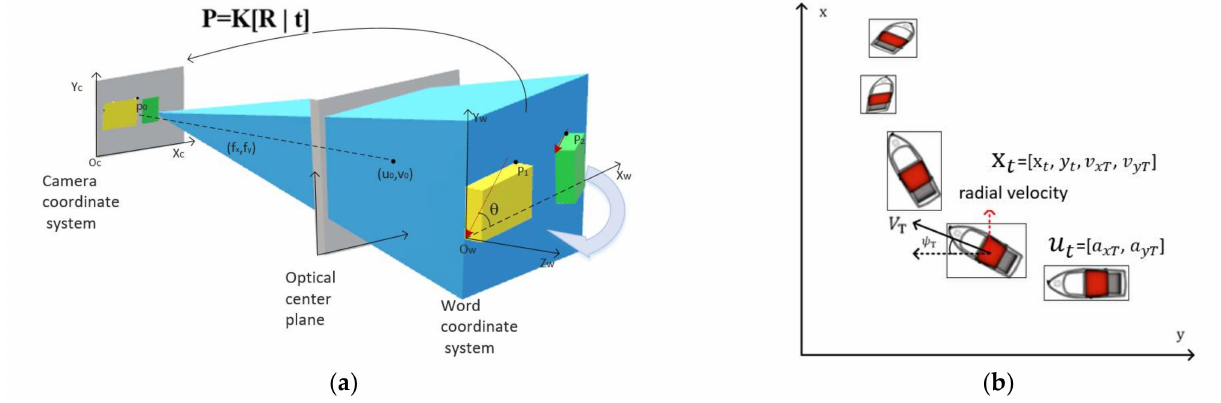
Figure 6. Measurement model of ship motion characteristics. ( a ) Three-dimensional model of ship image coordinate system to world coordinate system transformation. ( b ) The measurement model of ship motion